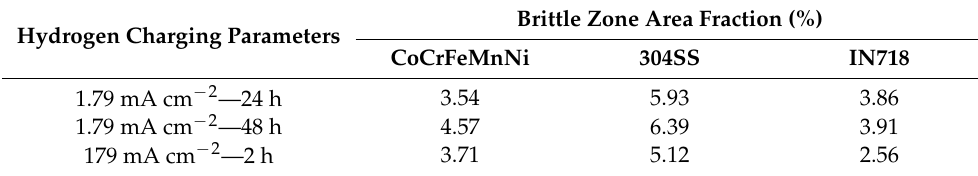
Table 4. Brittle zone area fraction of hydrogen-charged CoCrFeMnNi, 304SS and IN718